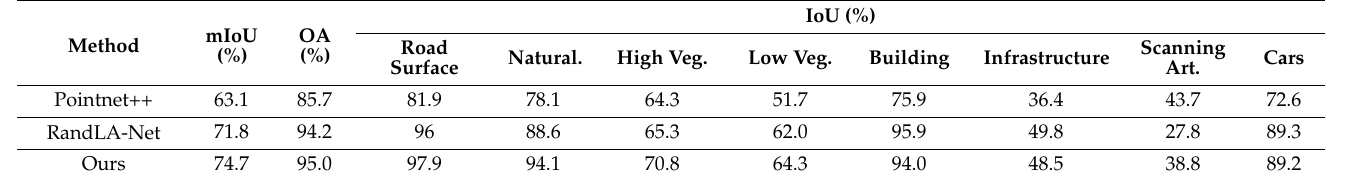
Table 2. Semantic segmentation (semantic-8) results of Semantic3D Dataset %.